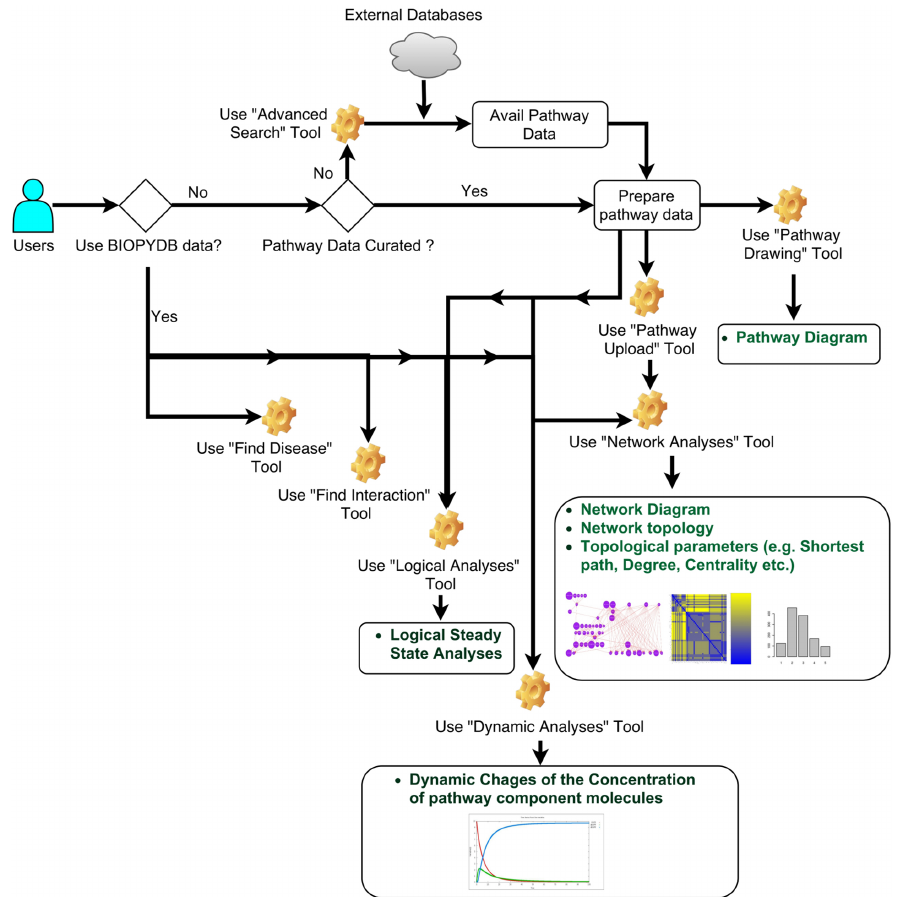
Figure 5: Schematic diagram showcasing all the available tools and their working